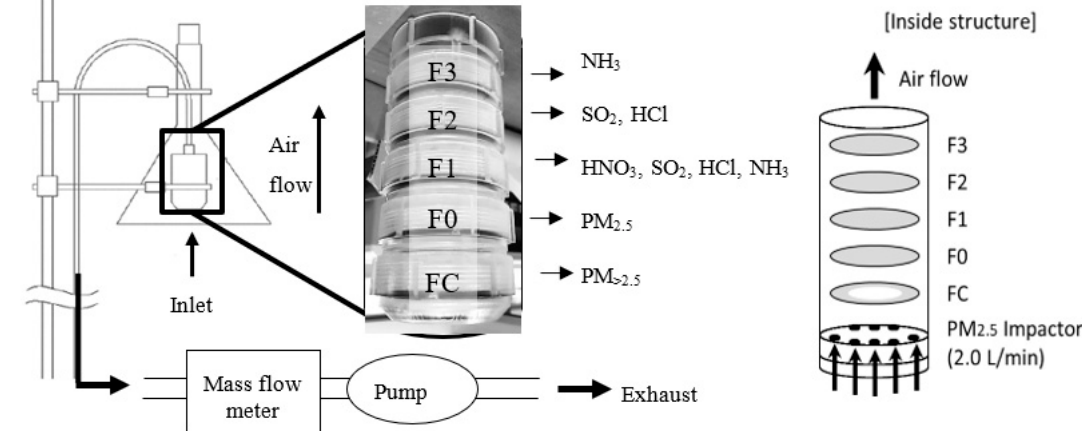
Figure A2. Schematic diagram of a five-stage filter pack sampler. A PM 2.5 impactor is installed at the sampling inlet to separate coarse (PM > 2.5 µ m) and fine (PM ≤ 2.5 µ m) particles. A doughnut shaped filter is used for collection of coarse particles. Fine particulate is passed though the center of the stage FC and collected on the F0 filter